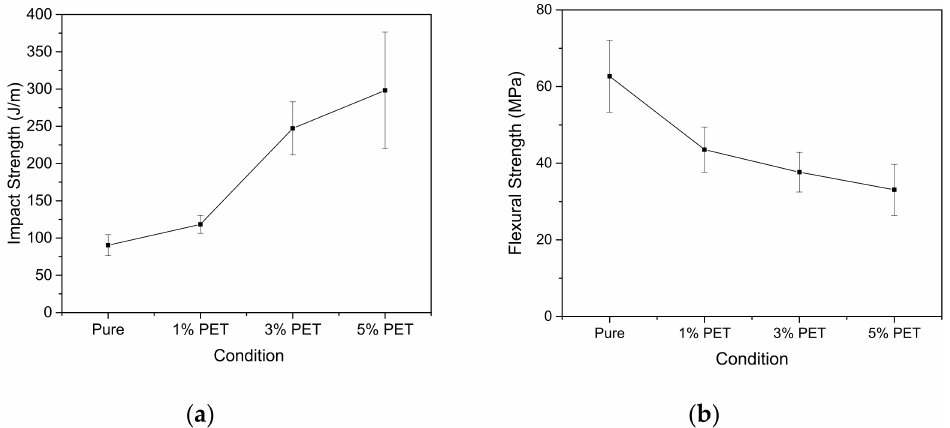
Figure 5. ( a ) Impact resistance; ( b ) Flexural